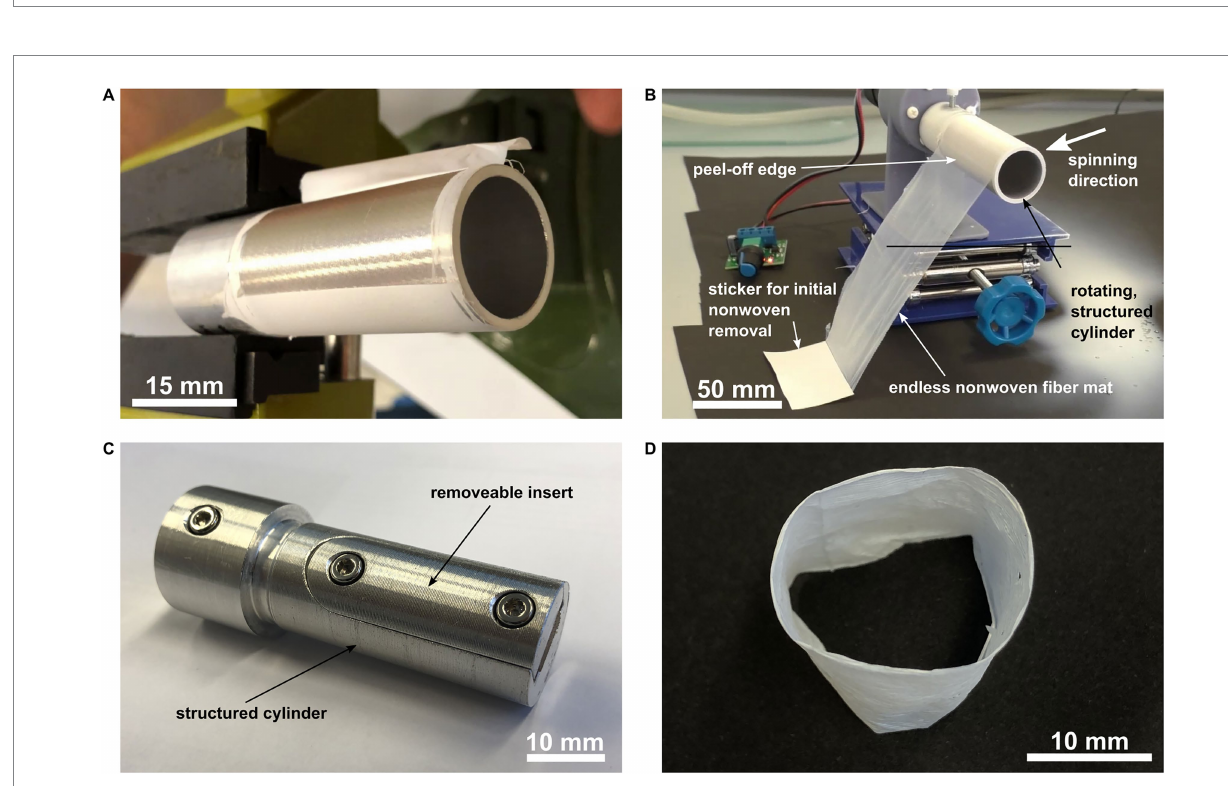
FIGURE 13 (A) Aluminum cylinder covered with the triangular surface structure. The nonwoven nanofiber layer can be peeled off from the cylinder easily. (B) Production of an endless nonwoven nanofiber mat. The surface-structured cylinder is slowly rotated anti clockwise. The nanofibers are electrospun from the right. During the slow rotation of the cylinder, the nonwoven layer polymerizes and can then be easily peeled off on the opposite side. By winding up the peeled off nanofiber layer, an endless nonwoven nanofiber mat can be produced. (C) Aluminum cylinder covered with triangular surface structure and additional removeable insert. The cylinder is again slowly rotated and electrospun until the whole cylinder is covered with a nanofiber layer. Subsequently, the removeable insert is removed carefully in the axial direction of the cylinder. Thereby the tension on the nonwoven layer is released and a tubular nanofiber layer can now be removed carefully in whole from the cylinder. (D) Tubular nanofiber nonwoven removed in whole from the cylindrical tool shown in (C) . Video S1 in the Supplementary material explains the principle of the two tool prototypes clearly and in more